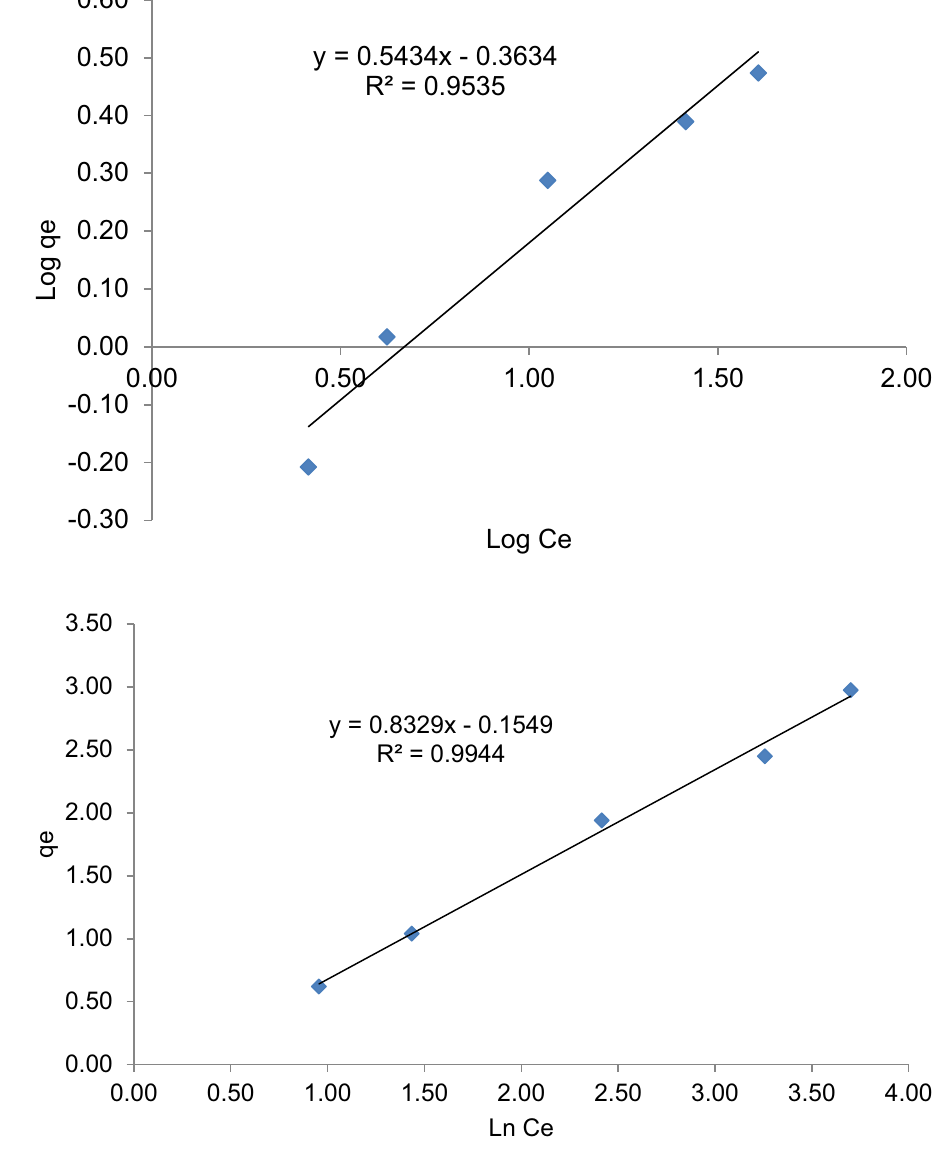
Fig. 8 Freundlich adsorption isotherm plot of Cr(VI) ion